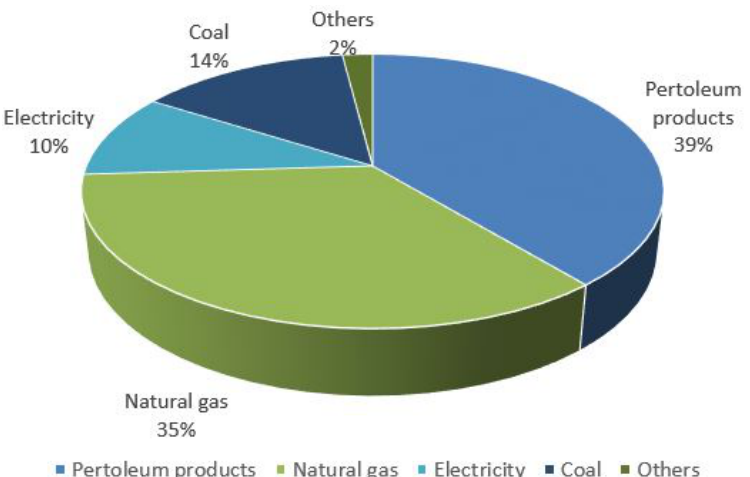
Figure 3. Key environmental issues in